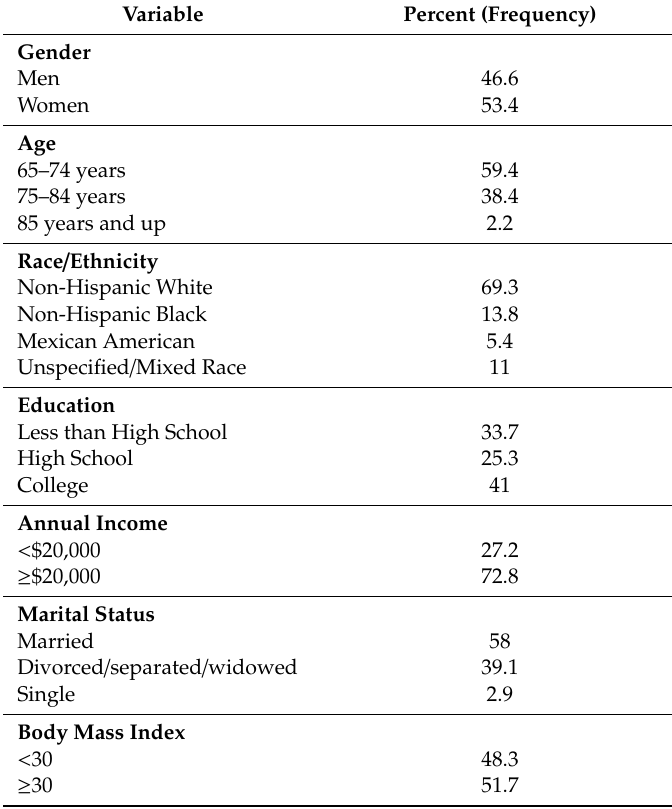
Table 1. Study sample demographics, The National Health and Nutrition Examination Survey (NHANES)